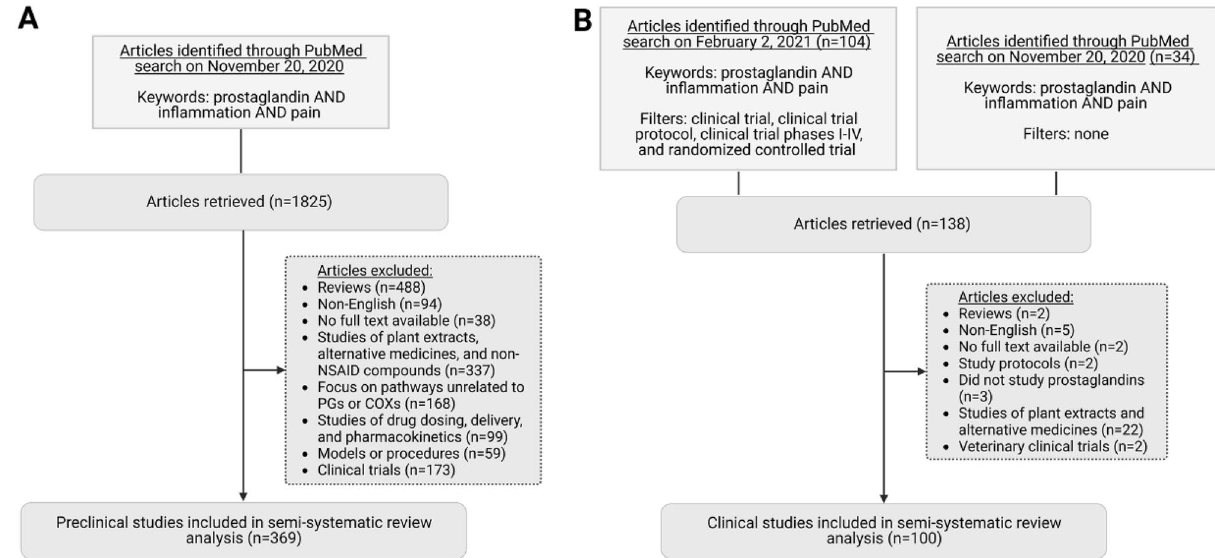
Figure 5. Semi-systematic review of articles retrieved on PubMed. ( A ) Workflow of pre-clinical studies identified through PubMed. ( B ) Workflow of clinical studies identified through